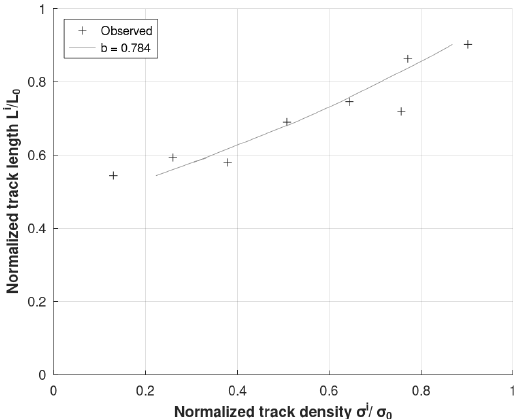
Figure C1. Parameter b characterizes the relation between normal- ized track length L i /L 0 and normalized density σ i /σ i compositional apatite. Data are from Green